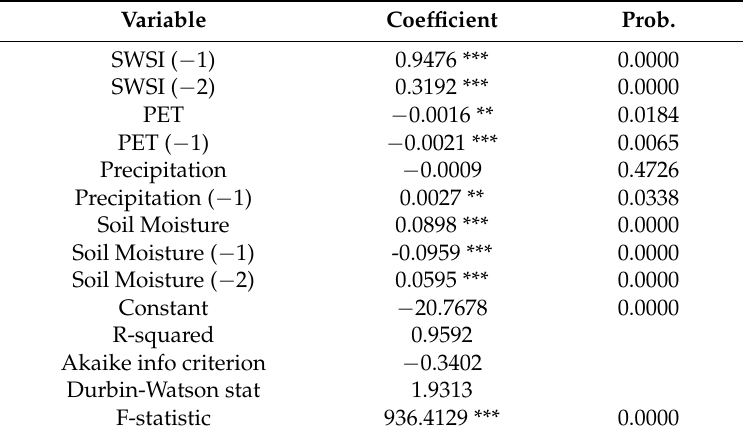
Table 4. The autocorrelation of HD and its dependence on precipitation, potential evapotranspiration (PET), and soil